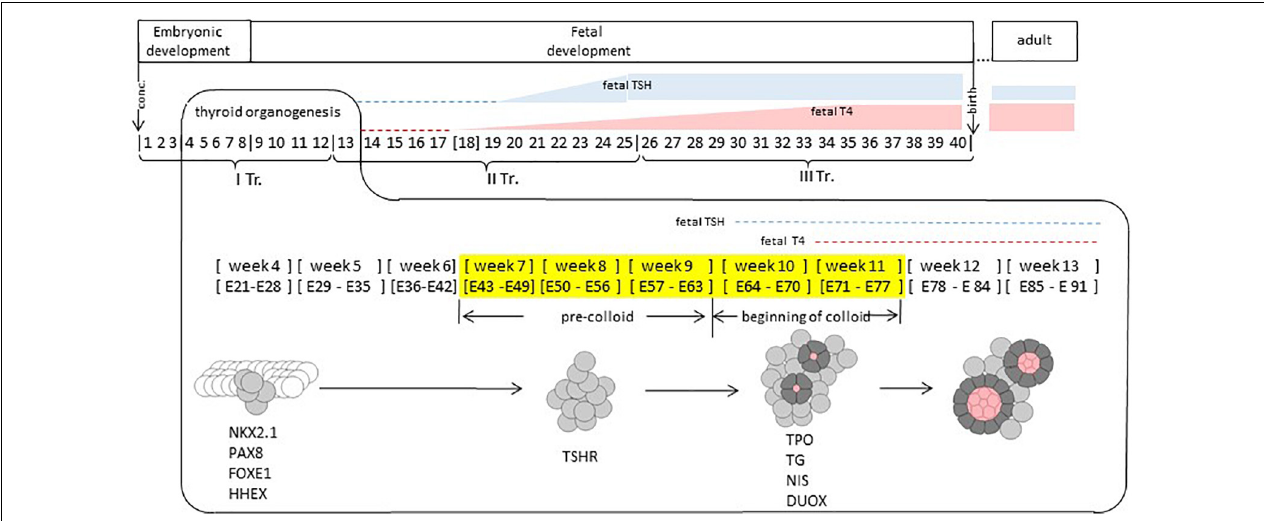
FIGURE 1 | Human thyroid development. Timeline of thyroid development. Thyroid organogenesis covers the embryonic and fetal periods. Thyroid fate determination happens prior to weeks 4. Specific transcription factors (NKX2.1, PAX8, FOXE1, and HHEX) are expressed at week 4. Thyroid progenitor cells migration occurs at weeks 4–7; TSHR (TSH receptor) is expressed at week 8. Thyroid functional differentiation: weeks 7–11, colloid appearing at weeks 10–11, when genes such as TPO, TG, NIS, and DUOX, coding for proteins involved in thyroid function are expressed. Thyroid maturation (GW 12 – 1 months after birth or later). TSH is present at week 10 at low concentration in fetal plasma, at week 20 it increases to reach a maximum level between weeks 20 and 30. Fetal TSH receptors become responsive to TSH around week 20. Week, gestational week. E, embryonic day. TR, gestational trimester. In yellow: gestational weeks covered by our study. Conc, conception.